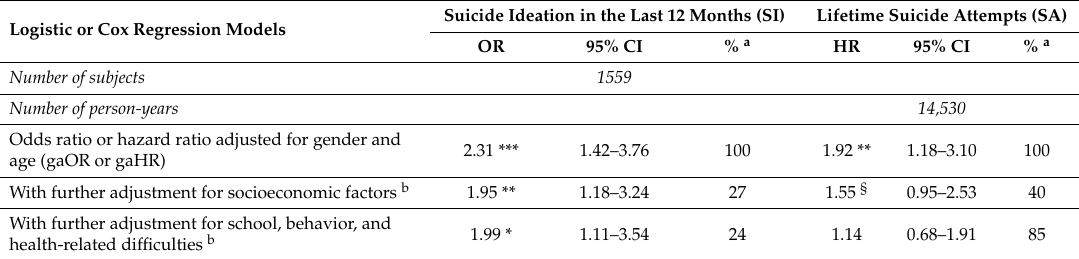
Table 4. Suicide behaviors for immigrant adolescents vs. French adolescents, and contribution of covariates: odds ratio (OR) or hazard ratio (HR) and 95% confidence interval